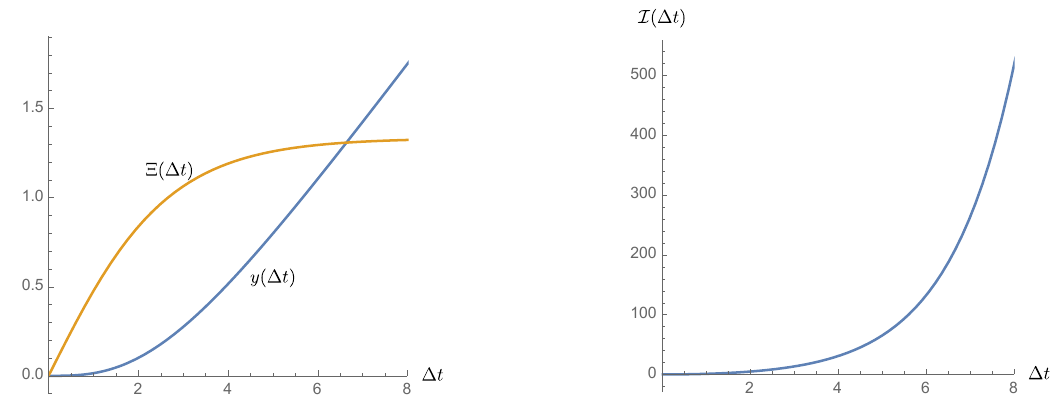
Figure 10 . Three functions which characterize the bulk geodesic in figure 9: the horizontal (cid:12) displacement y (∆ t ) needed for the signal to come back at a right angle; the parallax Ξ(∆ t ) (cid:12) ϕ y =0 in (4.7); the signal intensity I (∆ t ) from (4.4). Parameters again as in (4.6).